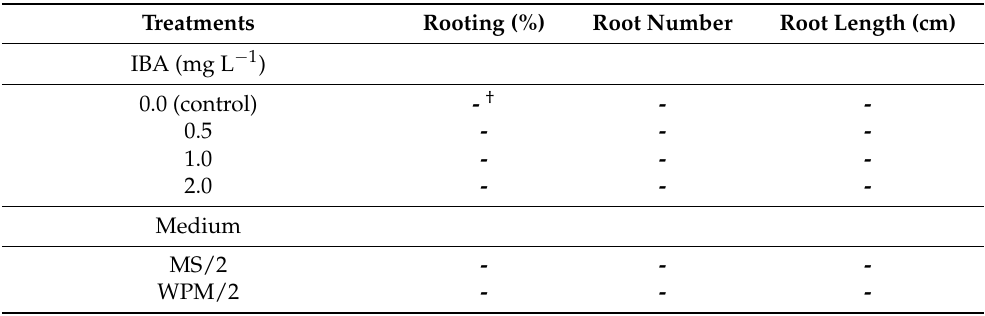
Table 6. In vitro rooting of microshoots derived in the multiplication stage affected by the